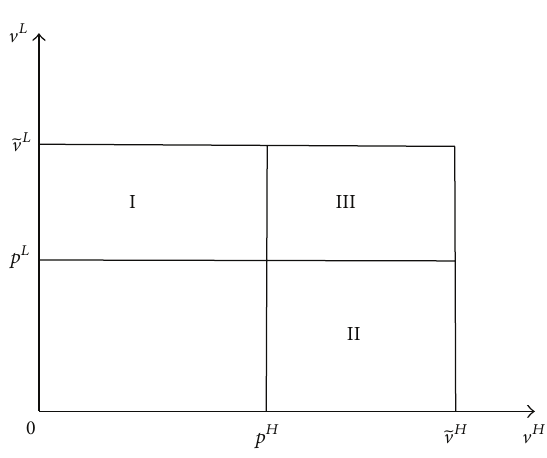
model parameters: 𝑝 𝐿 < V 𝐿 , 𝑝 𝐻 < V 𝐻 , 𝑠 < 𝑐 < 𝑝 𝐿 , and 𝑠 < 𝑐 < 𝑝 𝐻 . The key notations used in this paper are summarized in Notation